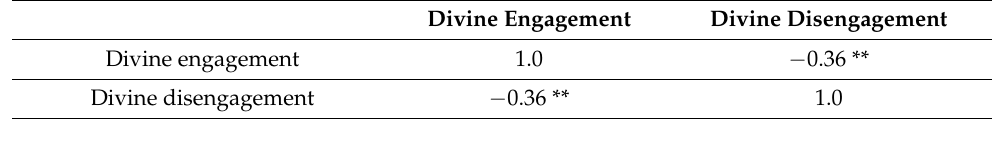
Table 6. Correlations of Key Variables with Divine Engagement and Disengagement (Sample 2; N =